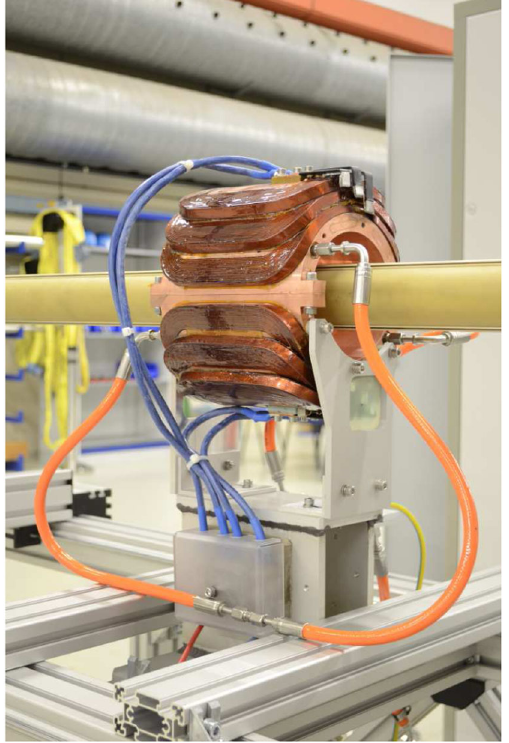
FIG. 17. Picture of the coil-dominated corrector